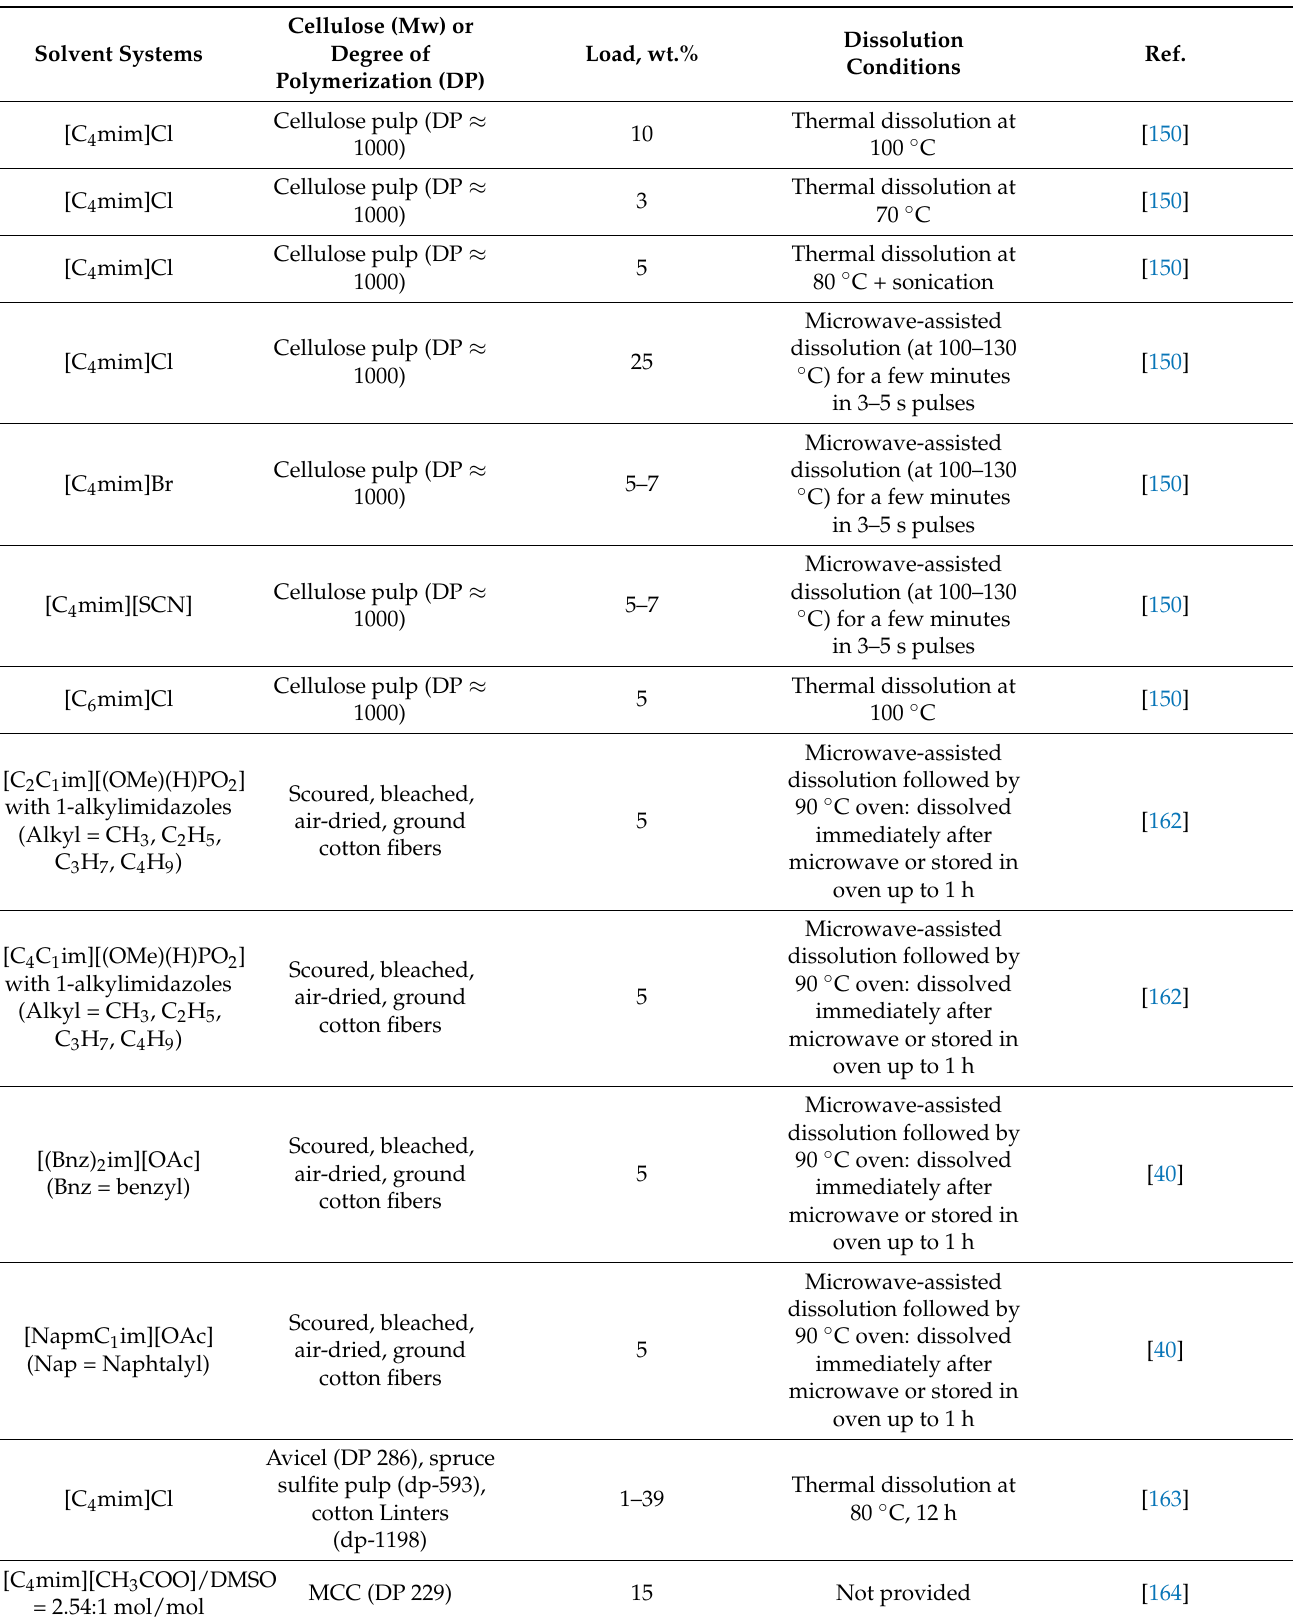
Table 3. Representative examples of cellulose dissolution in